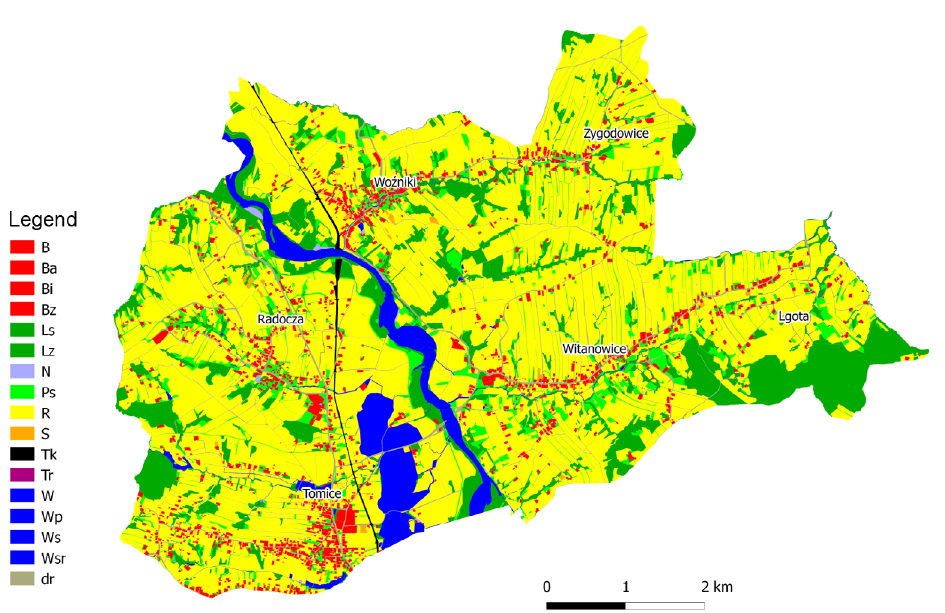
Fig 1. Spatial diversity of land use in the Tomice commune; source: own study using the QGIS